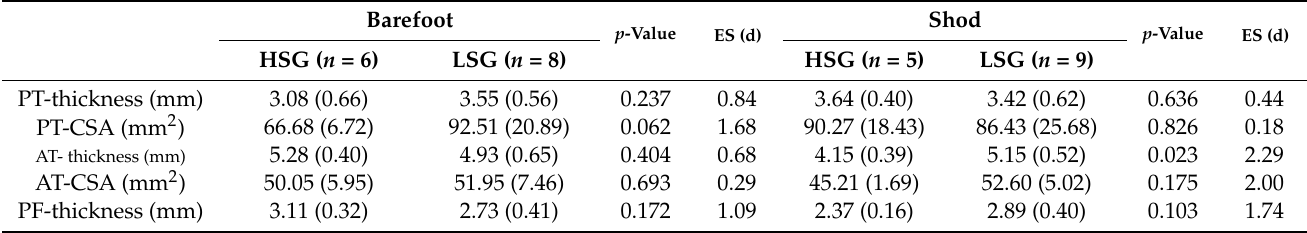
Table 3. Connective tissue morphology regarding lower-limb stiffness groups in both barefoot and shod conditions (ANOVA). Barefoot p